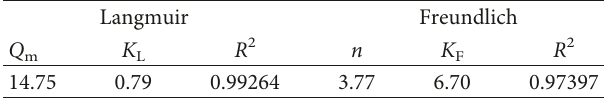
Table 5: Experimental constants Q m , K L , K F , and n in Langmuir and Freundlich equations.